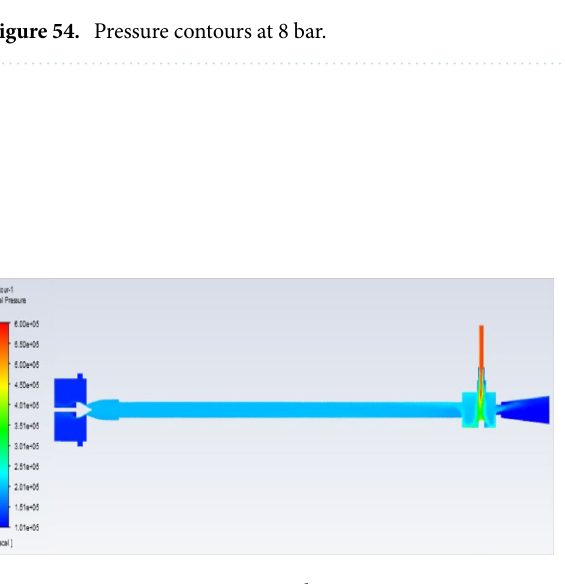
Figure 55. Pressure contours at 10